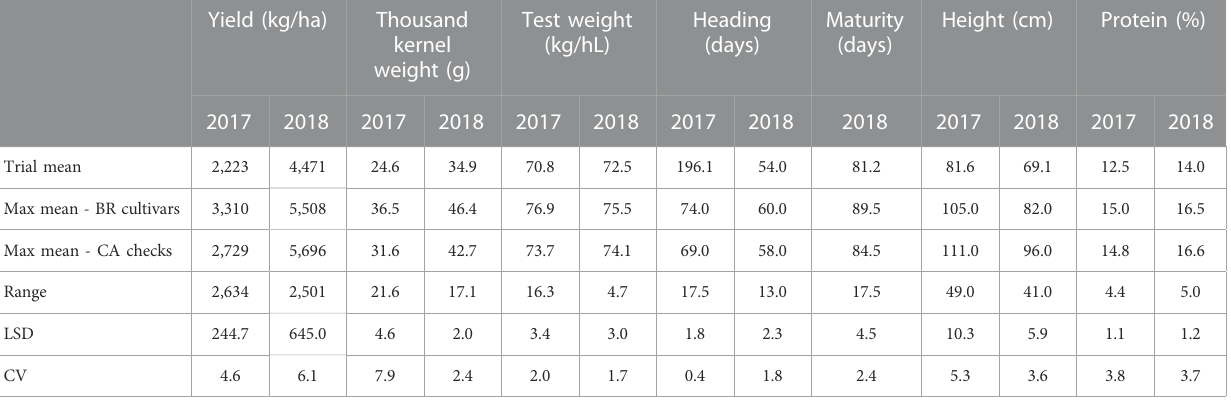
TABLE 2Mean of trial, maximum mean among Brazilian cultivars andamong Canadian checks,range, least signi fi cantdifference(LSD) andcoef fi cient ofvariation (CV) of agronomical traits in two fi eld trials in east Canada in 2017 (Ottawa, ON) and 2018 (St-Mathieu-de-Beloeil, QC). Test weight Yield (kg/ha) Thousand (kg/hL) kernel weight (g)